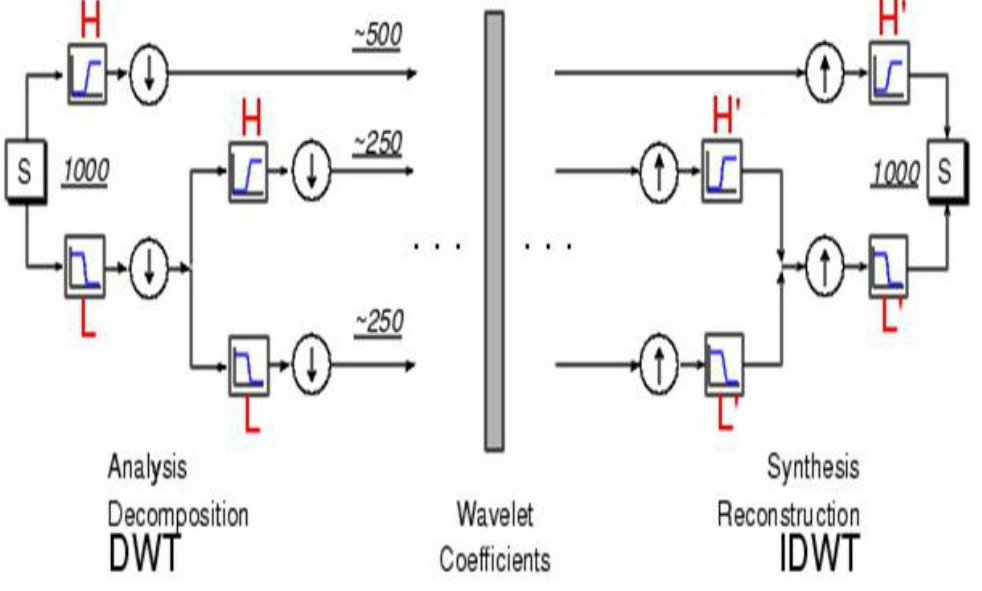
Figure 3. Decomposition ( left ) and reconstruction ( right ) of a signal to/from its coefficients. Decomposition is done by convolving the signal (S) of length n = 1 , 000 with a high-pass filter (H) and low-pass filter (L) and then downsampling. The next scale is similarly obtained by convolving the first level approximation with these filters, etc . Reconstruction is achieved by upsampling and then convolving the upsampled vectors with “mirror filters”. (from Matlab’s Wavelet Toolbox